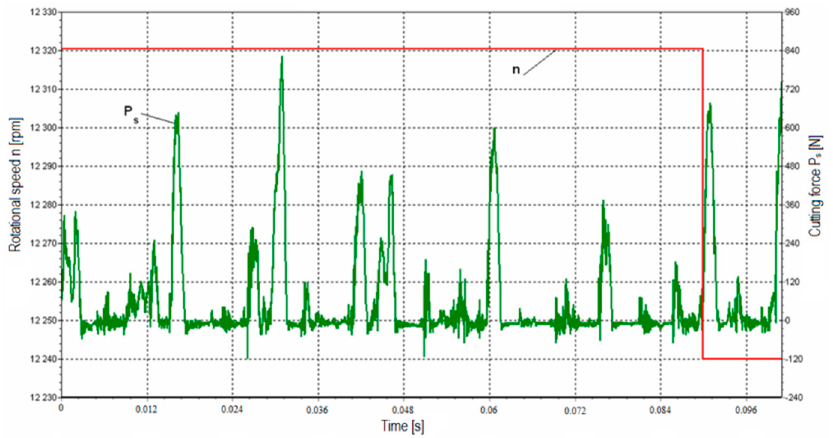
Figure 5. Cutting force variability at a feed force of 51 N.